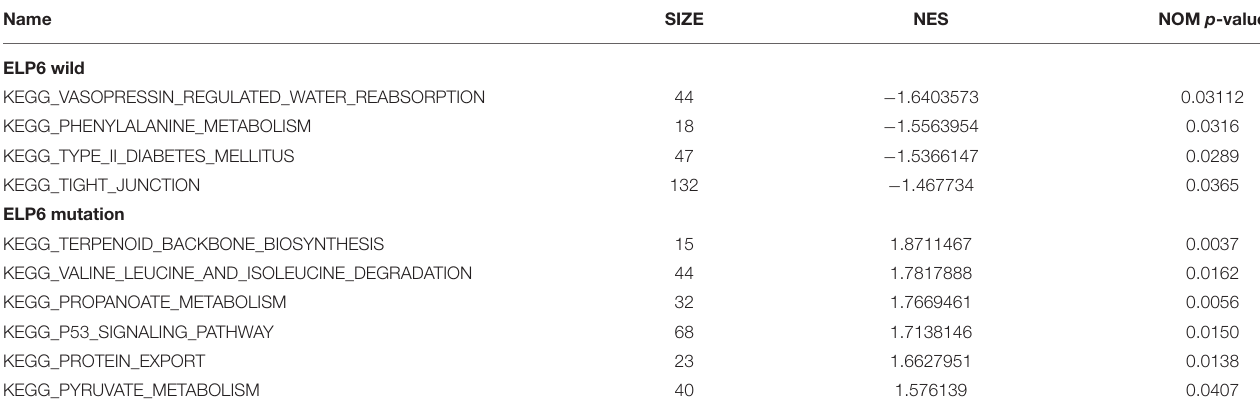
TABLE 2 | GSEA-enriched KEGG pathways in ELP6 wild and ELP6 mutation.